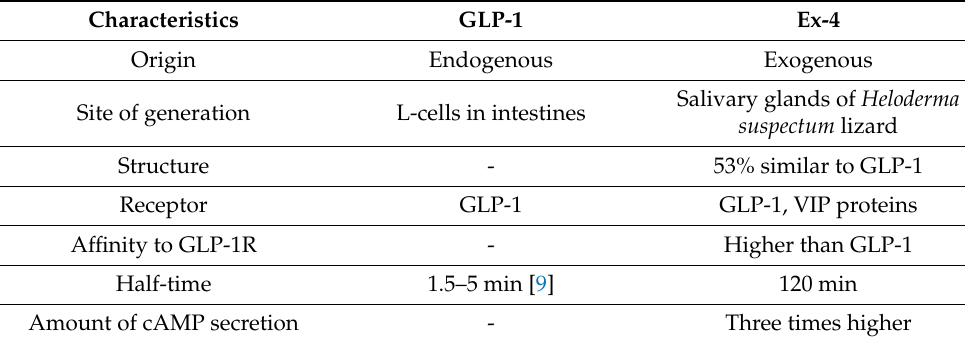
Table 1. Comparison of GLP-1 and